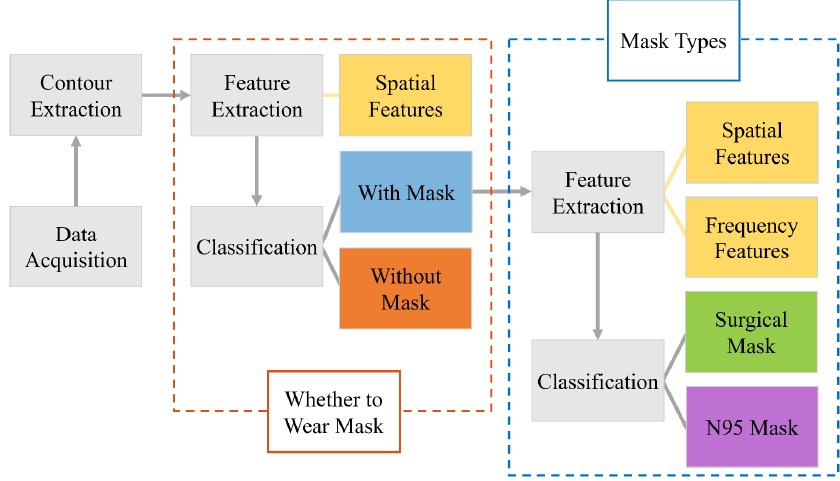
Figure 1. Flow chart of mask recognition based on depth camera .